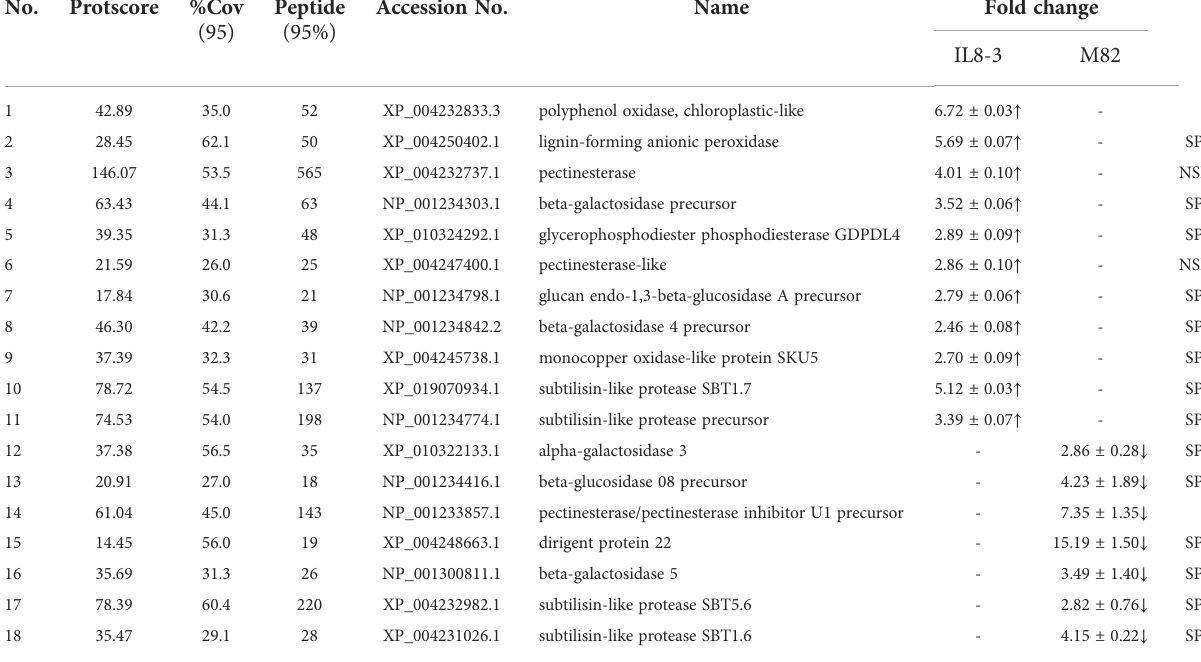
TABLE 2 Differentially abundant proteins (DAPs) related to cell wall metabolism that identi fi ed from IL8-3 and M82 under salt stress. No.